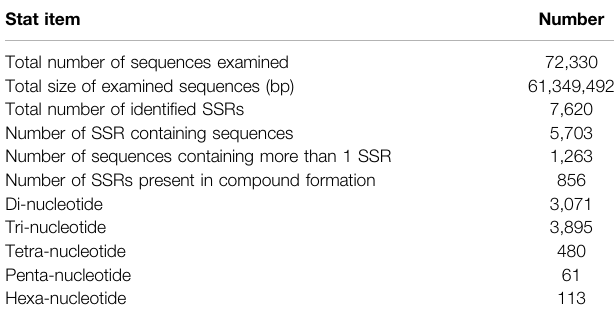
TABLE 3 | Parameters of the SSRs obtained from the sequences examined in the